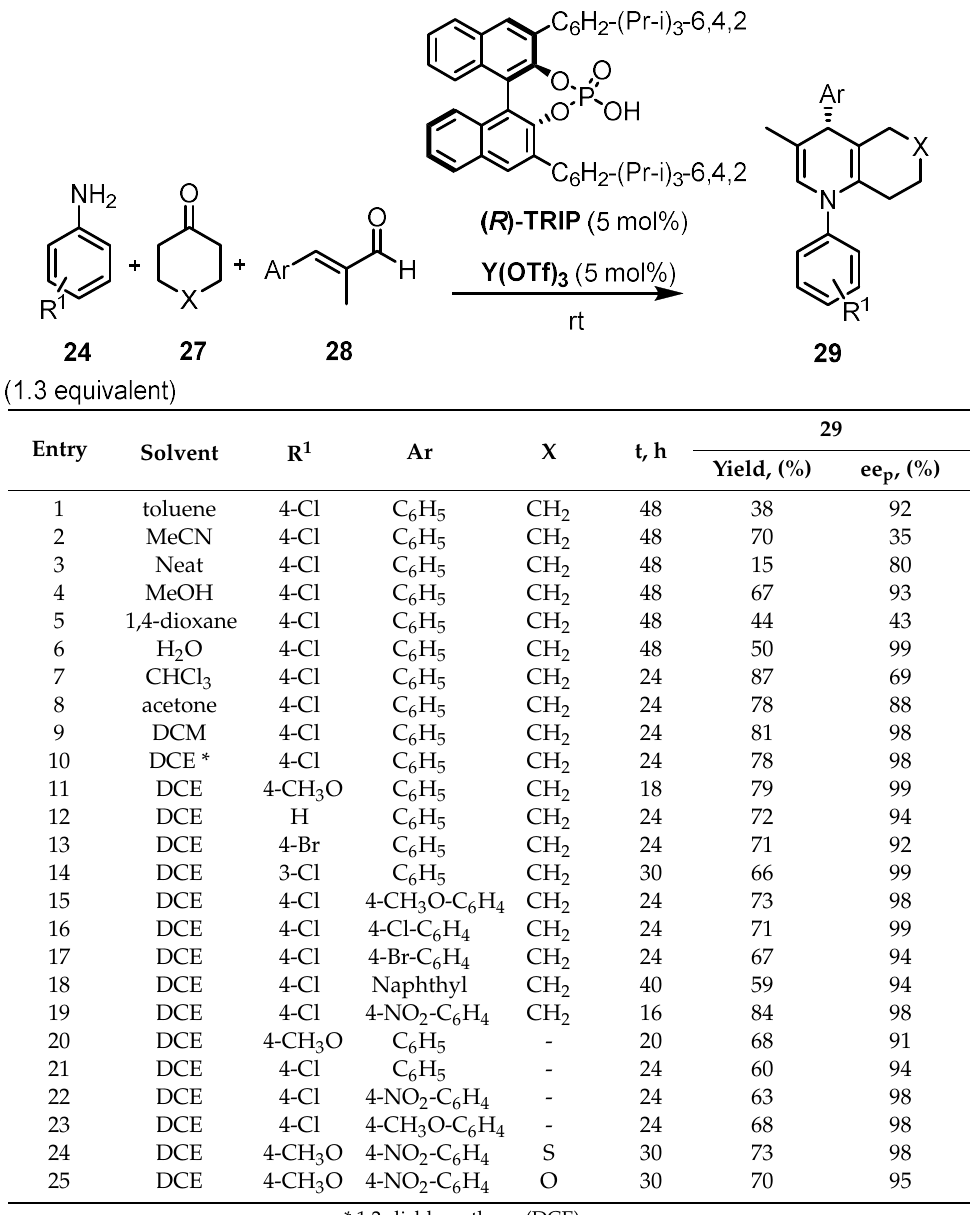
Table 10. Chiral BINOL-derived phosphoric acid, hard metal Lewis acid, and amine catalysed synthesis of 1,4-DHP 29 [68].